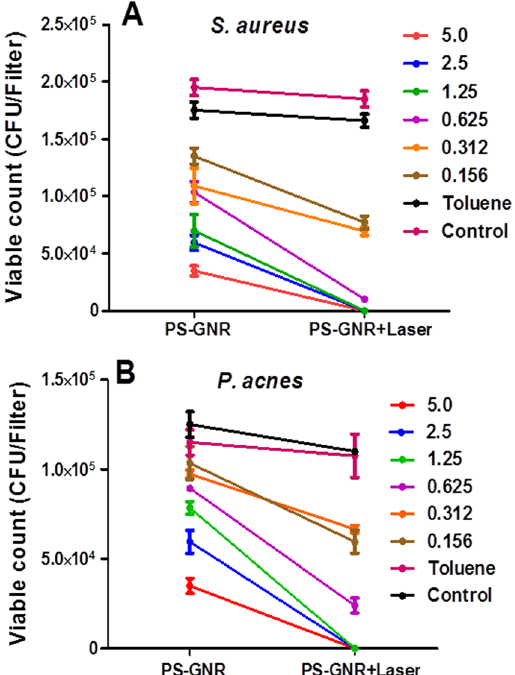
Figure 5. Effect of NIR laser exposure of bacteria pre-treated with PS-GNR. ( A ) Bacterial viable count of S . aureus treated with different concentrations (nM) of PS-GNR compared to those treated with PS-GNR followed by exposure to laser beam. ( B ) Bacterial viable count of P . acnes treated with different concentrations (nM) of PS-GNR compared to those treated with PS-GNR followed by exposure to laser beam. Control: bacteria exposed to laser beam alone without GNR.